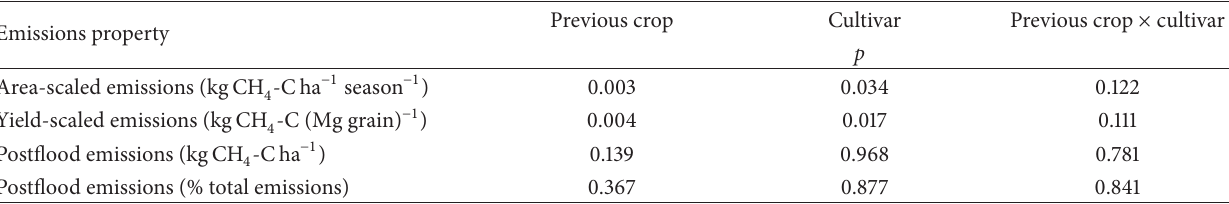
Table 4: Summary of the effect of previous crop, cultivar, and their interaction on seasonal methane (CH 4 ) emissions from a clay soil during the 2013 growing season at the Northeast Research and Extension Center in Keiser, Arkansas.